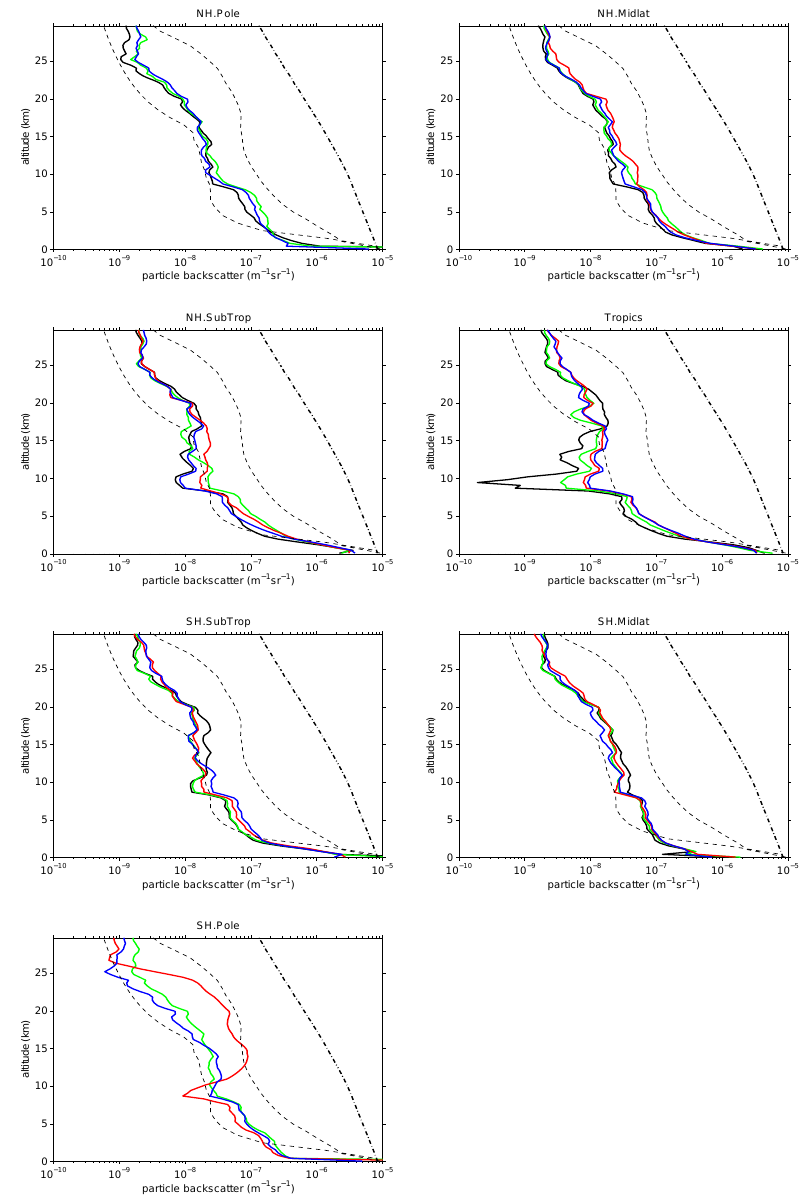
Fig. 8. CALIPSO median aerosol backscatter (m − 1 sr − 1 ) at 355nm wavelength for January (black), April (green), August (red) and October (blue) 2007. The dashed lines represent the reference “clean” and ”dirty” median aerosol backscatter profiles and the dash-dotted line is molecular backscatter similar as in Fig. 7. The reference curves are fixed for all climate zones.